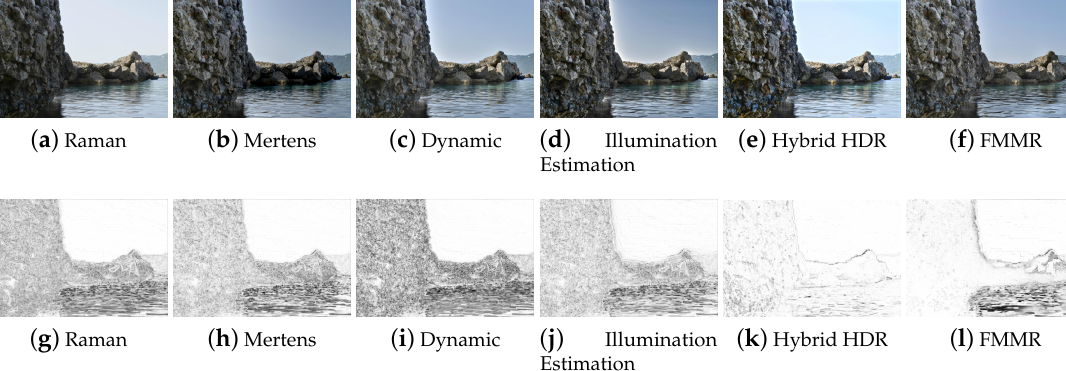
Figure 6. Comparison of the six MEF algorithms using the “Flowers” images.